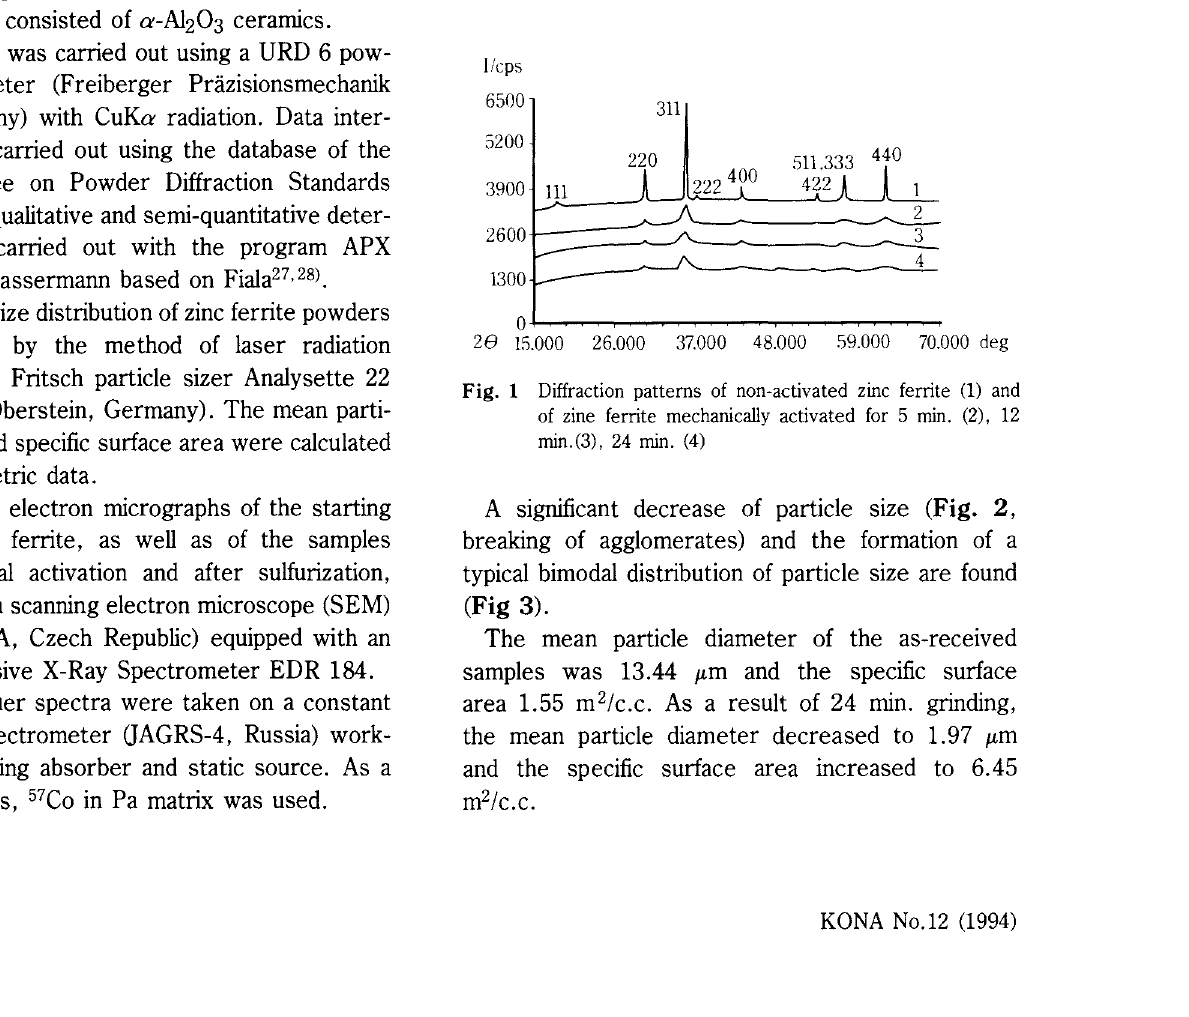
Fig. 1 Diffraction patterns of non-activated zinc ferrite (1) and of zine ferrite mechanically activated for 5 min. (2), 12 min.(3), 24 min.